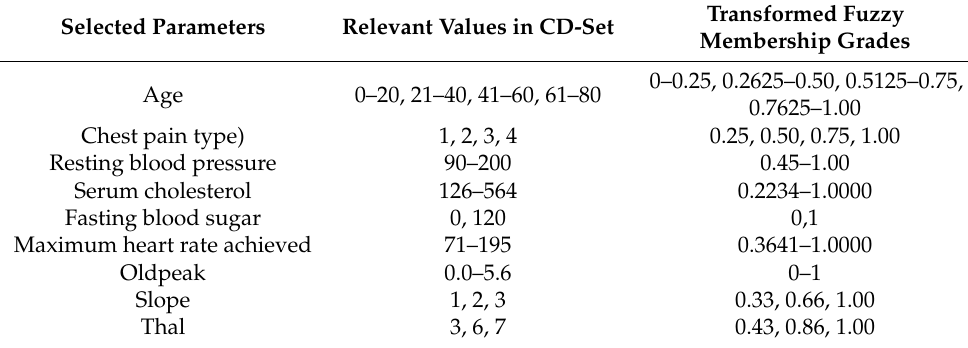
Table 3. Fuzzy-values-based ranges of opted